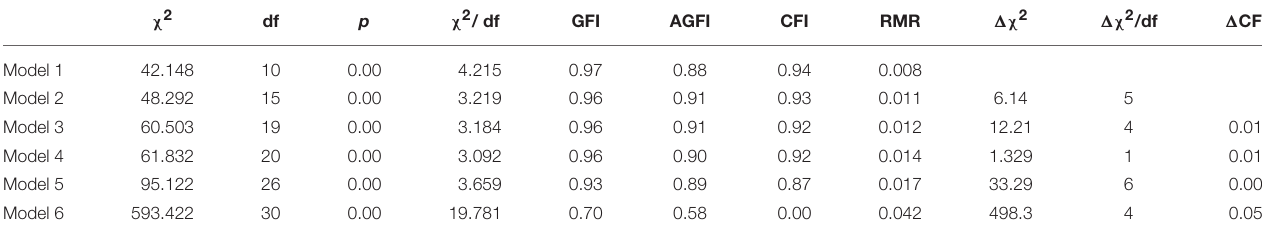
TABLE 3 | Comparative indexes for first model (dimension parental support).